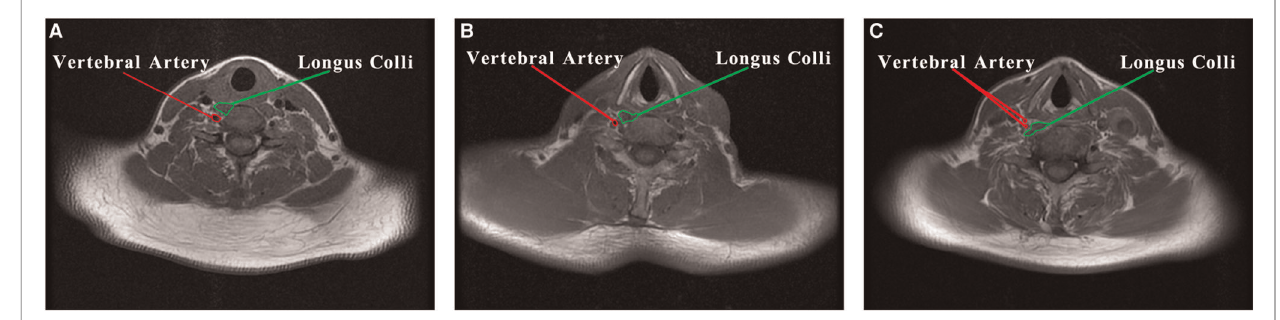
FIGURE 6 | Anatomic relationship between vertebral artery and longus colli: ( A ) the vertebral artery located at the posterior medial margin of the longus colli (26/30), ( B ) the vertebral artery located at the lateral margin of the longus colli (3/30), ( C ) the vertebral artery located at the anterior margin of the longus